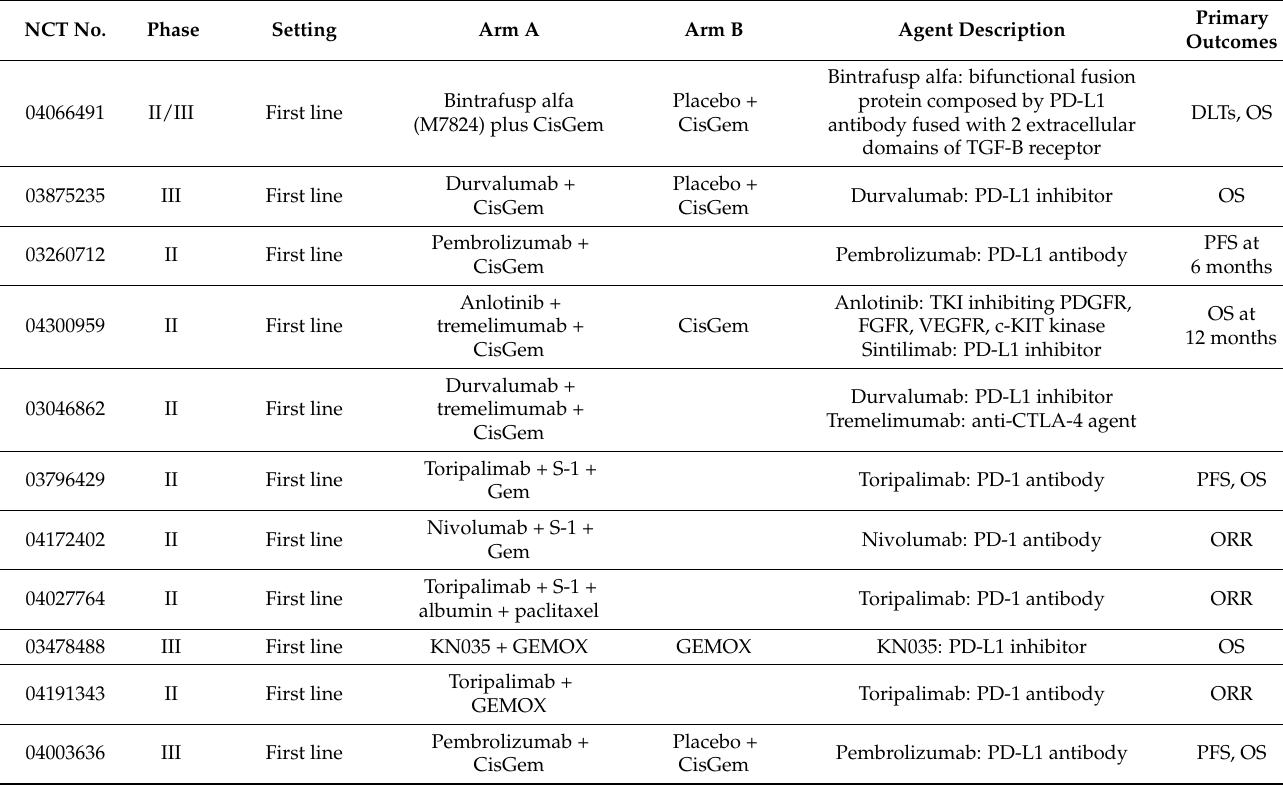
Table 2. Ongoing Phase I-III clinical trials evaluating immune checkpoint inhibitors in biliary tract cancer patients with advanced disease [43]. NCT